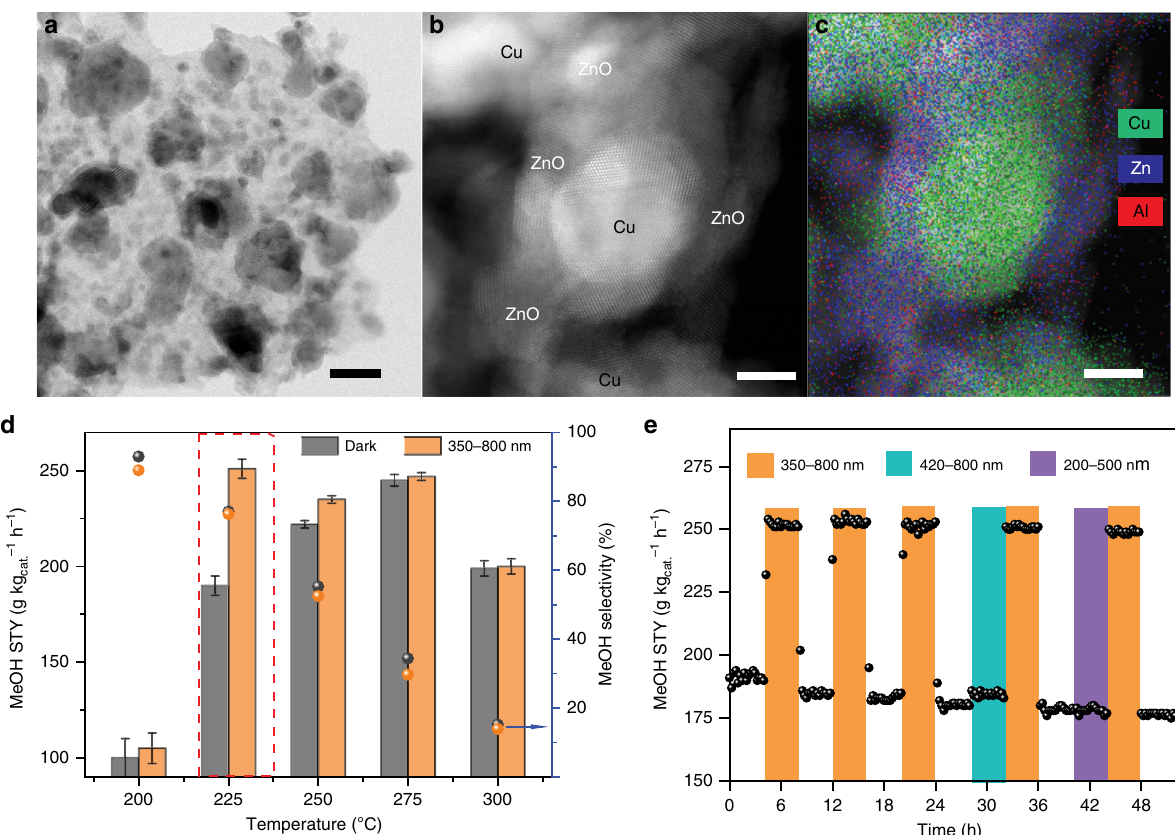
Fig. 1 Structural properties and catalytic activities. a , b HR-TEM images and c EDS map of reduced CZA catalyst, scale bar, 25 nm ( a ) and 5 nm ( b , c ); d MeOH selectivity/space time yield (STY) at 200 – 300 °C under dark and 350 – 800 nm light irradiation (red dotted box indicates the highest photo- enhancement at 225 °C). Error bars indicate the deviation among three independent experiments; e time-on-stream MeOH yield under different light irradiation conditions (350 – 800 nm, 200 – 500 nm, and 420 – 800 nm, which corresponds to the excitation of Cu, ZnO, and Cu + ZnO, respectively). Reaction conditions: CO 2 : H 2 = 1: 3.2, GHSV = 8758 h − 1 , P = 21 bar, T = 225 °C, light intensity = 600 mWcm − 2 for all spectral